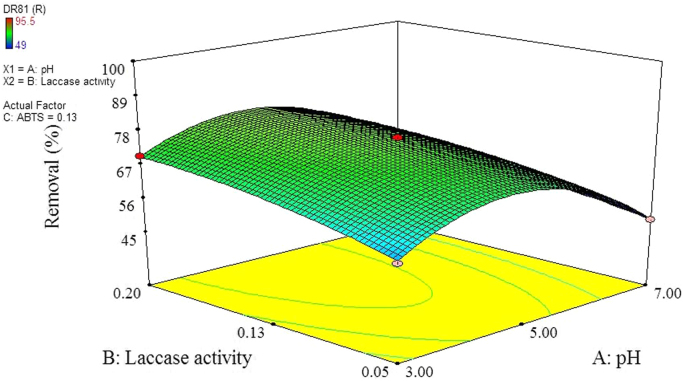
3D surface plot from BBD showing the interaction effects of pH and laccase activity on elimination of DR81.